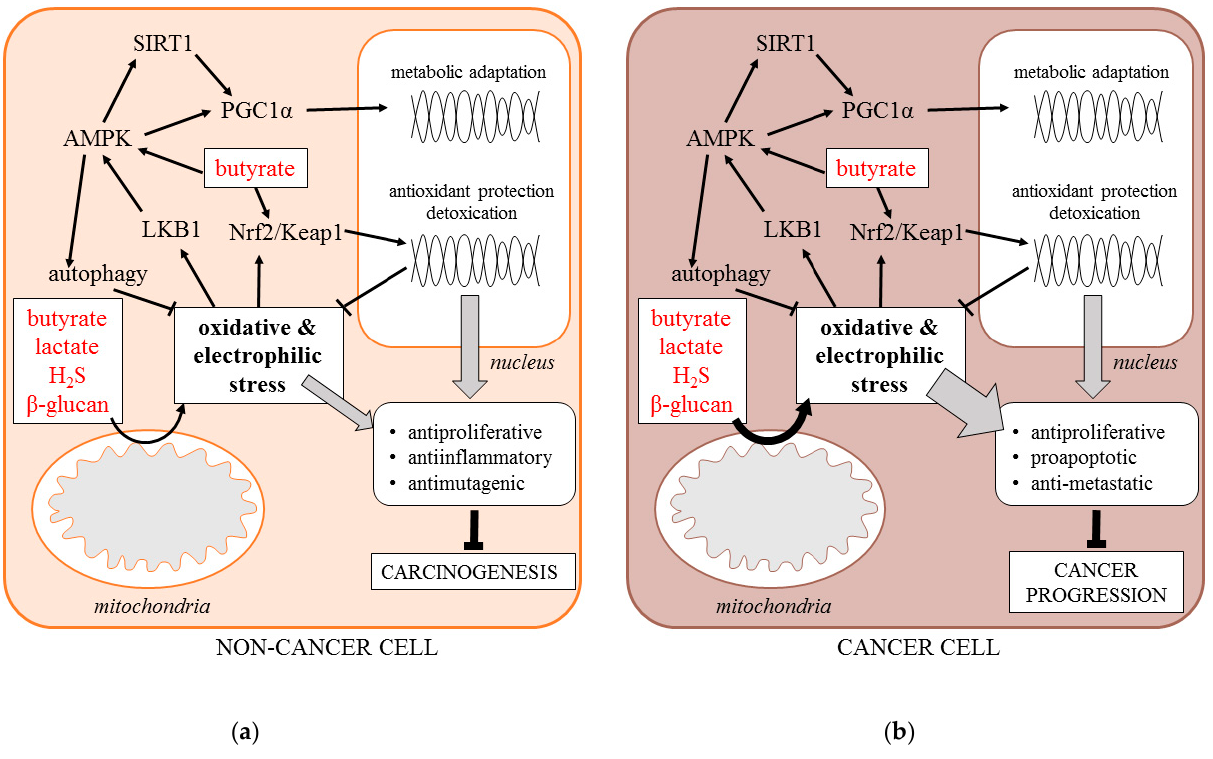
Figure 1. Signaling response of non ‐ cancer ( a ) and cancer cell ( b ) to postbiotics (AMPK—5’ AMP ‐ activated protein kinase , H 2 S—hydrogen sulfide, Keap1—Kelch Like ECH Associated Protein 1, LBK1—liver kinase B1, Nrf ‐ 2—Nuclear factor erythroid 2 ‐ related factor 2, PGC1 α —Peroxisome proliferator ‐ activated receptor gamma coactivator 1 ‐ alpha, SIRT1— Sirtuin 1).